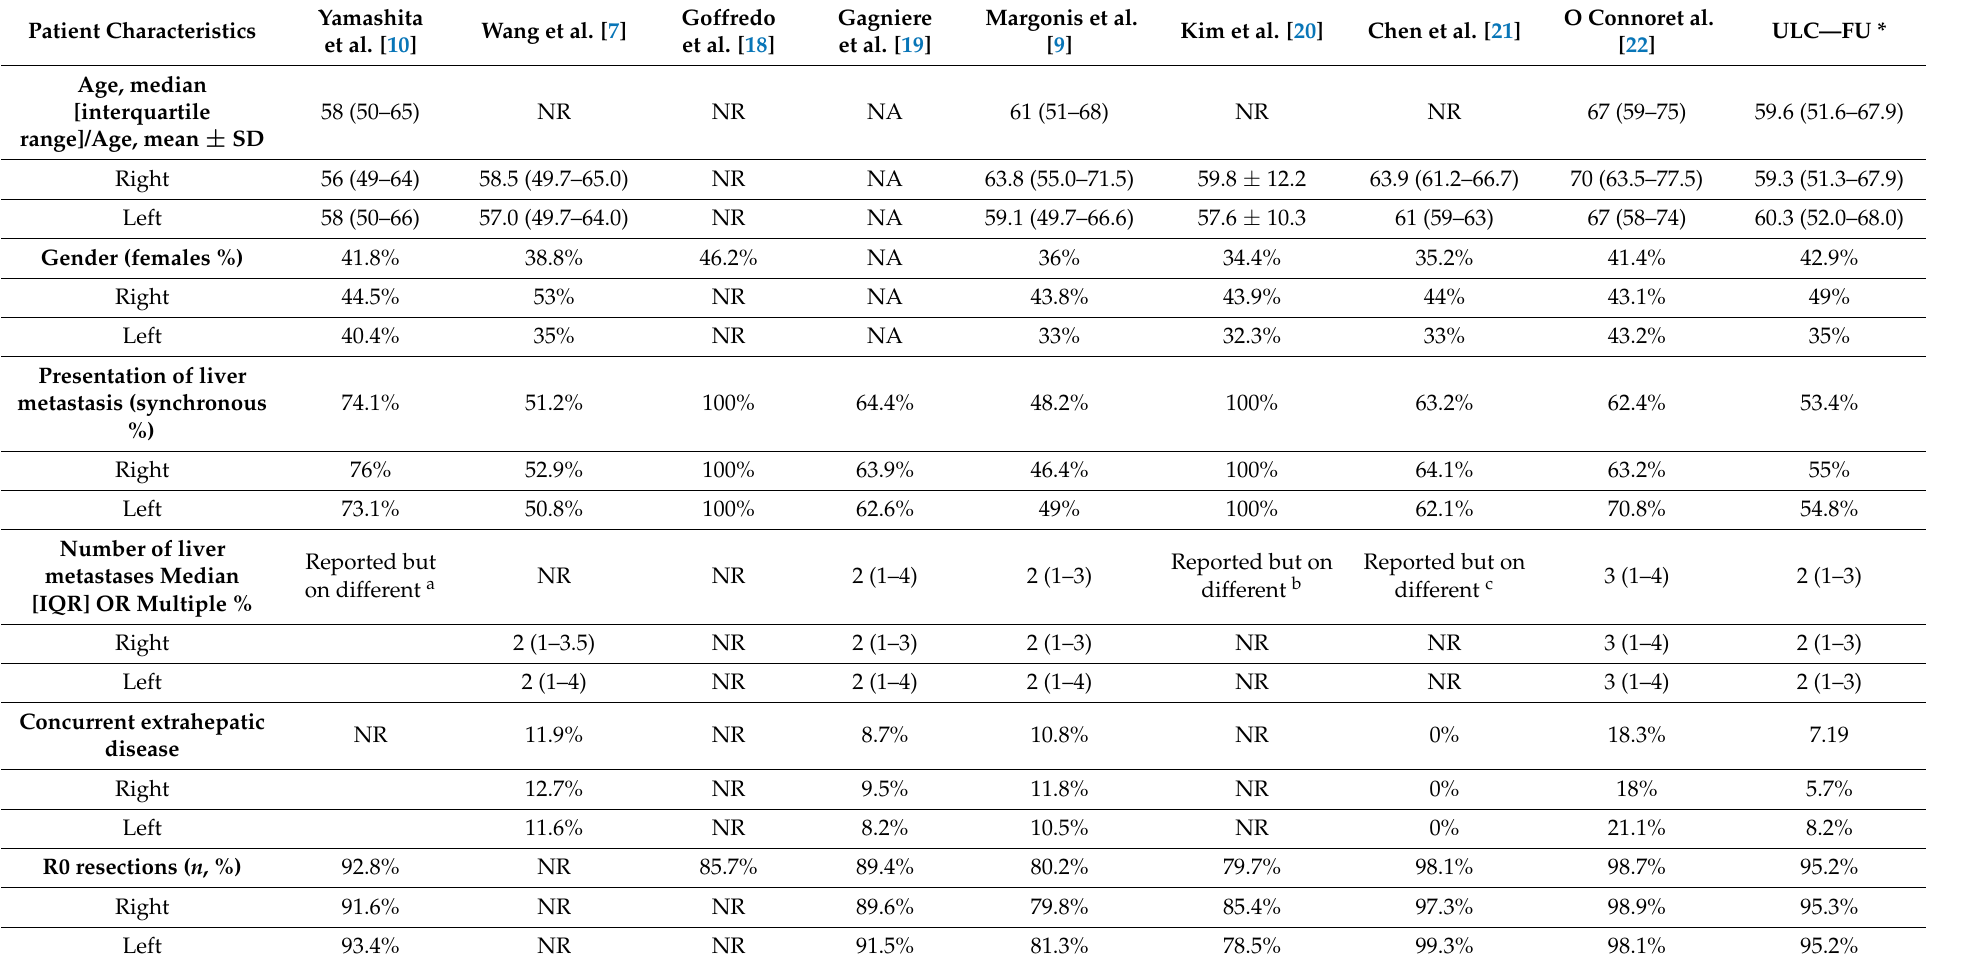
Table 2. Demographic-, tumor- and treatment-related patient